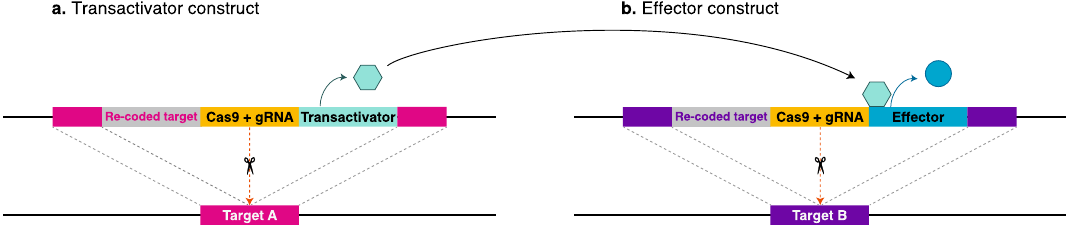
Figure 1. Binary expression drive constructs. Left: the transactivator construct ( a ). Right: the effector construct ( b ). The promoter of the transactivator gene is only active in the target tissue/organ, for instance, the ovaries or the male accessory glands. The transactivator protein will activate the expression of the effector gene, which encodes a dominant or semidominant toxin, in the target tissue/organ. In both constructs, the expression of Cas9 and the gRNA is under the regulation of a germline promoter that allows drive conversion during meiosis. Ideally, target loci are highly conserved genes that cannot tolerate mutations so resistance alleles are selected out of the population while each drive allele alone, carrying a re-coded target gene, will not impose an intended fitness population. In many species, however, finding haplosufficient endogenous genes may be challenging, not only because it requires a deep and comprehensive knowledge of female and male fertility/viability genetics but also because many of the essential genes involved in female fertility/viability may affect pleiotropically other life-history traits and/or may not be largely haplosufficient (i.e., mutant heterozygotes may experience reduced fertility/viability), both of which impede drive spread. We propose that the haplosufficiency limitation of suppression drives may be significantly reduced by deploy- ing a double CRISPR-based gene drive design to spread a split binary expression system. One drive would carry a transactivator factor (Fig. 1a) and the other would carry a dominant or semidominant lethal/toxic effector (Fig. 1b). As part of a binary expression system, the effector would only be expressed in the presence of the transactivator protein, so the system would impose a low fitness cost at its introduction and may allow each drive alone to rapidly spread from rare. After some generations, only when each drive reaches sufficiently high frequencies, both system components would have meaningful chances to co-occur within an individual. At this point the effector would be expressed killing or sterilizing the individual, eventually leading to a decline in the target population. We refer to this double gene drive design as the Binary Expression Drive (BED). The concept is similar to the ‘interacting drives’ approach proposed by Esvelt et al. 6 . However, while the ‘interacting drives’ approach achieves suppression effects by disrupting native, essential genes, BED aims to cause the expression of non-native, dominant toxins. BED could be used, for instance, to spread intracellular toxic proteins to be specifically expressed in the female reproductive organs so adult females carrying both the transactivator and the effector constructs would be sterilized. We will refer to this design as ‘female fertility BED’ (ffBED). The BED concept could be modified to spread engineered seminal proteins designed to be activated in the uterus and kill or sterilize females. We will refer to this design as a ‘seminal BED’ (sBED). Males carrying a sBED will behave as "terminators" of females, transferring into them lethal toxins. Nonetheless, such artificial seminal toxins are currently hypothetical. In polyandrous species, where females mate with several males, terminator males will be able to kill more than one female, thus making the intervention more efficient than it would be in monogamous species. Here, we developed a model for stochastic simulations in the R programming language to study the behavior of BEDs and compare it to female fertility single drives (ffSD) targeting a haplosufficient but essential female fertility gene. In both BED designs described here (female fertility or seminal), the transactivator and effector constructs are inserted into unlinked autosomal loci that are essential for embryonic development (so resistance alleles are selected out of the population). In the ffBEDs, the transactivator construct is exclusively expressed in the ovary, and the effector construct encodes a toxin that sterilizes the female. In the sBEDs, the transactivator construct is only expressed in the male accessory gland, and the effector construct encodes a seminal toxin that is innocuous to the male that produces it but lethal to the female that receives it via the ejaculate during copula- tion. In ffSDs, the target gene is essential for female fertility but has no effect on male fitness. The model assumes a panmictic population with discrete, non-overlapping generations. Each generation